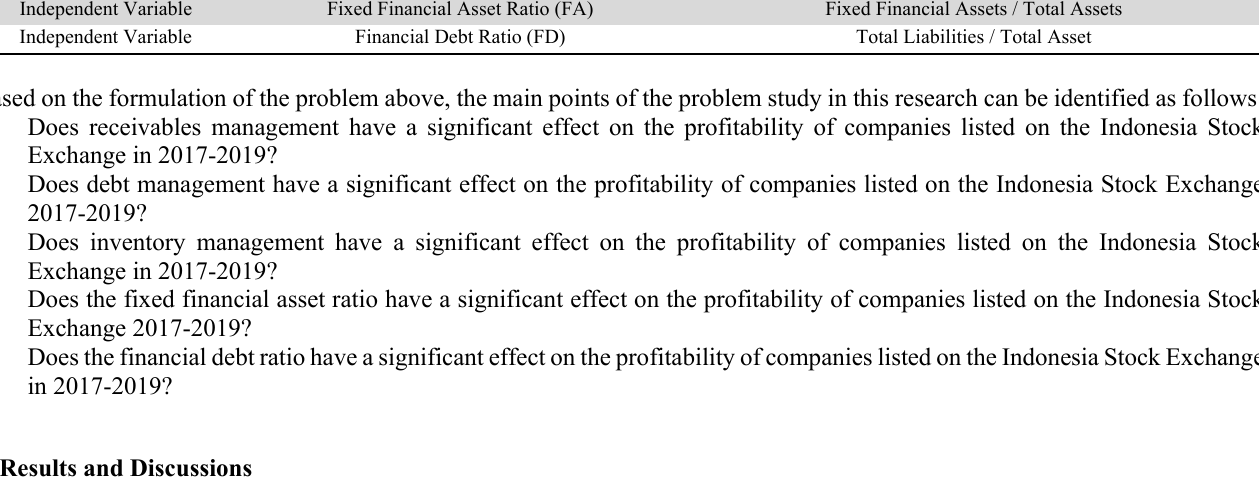
The results of One-Sample Kolmogorov-Smirnov Test N 138 Normal Parameters a,b Most Extreme Differences